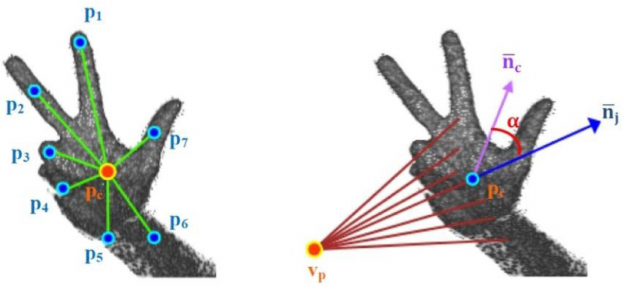
Figure 7. Viewpoint information of the VFH descriptor of a human hand.